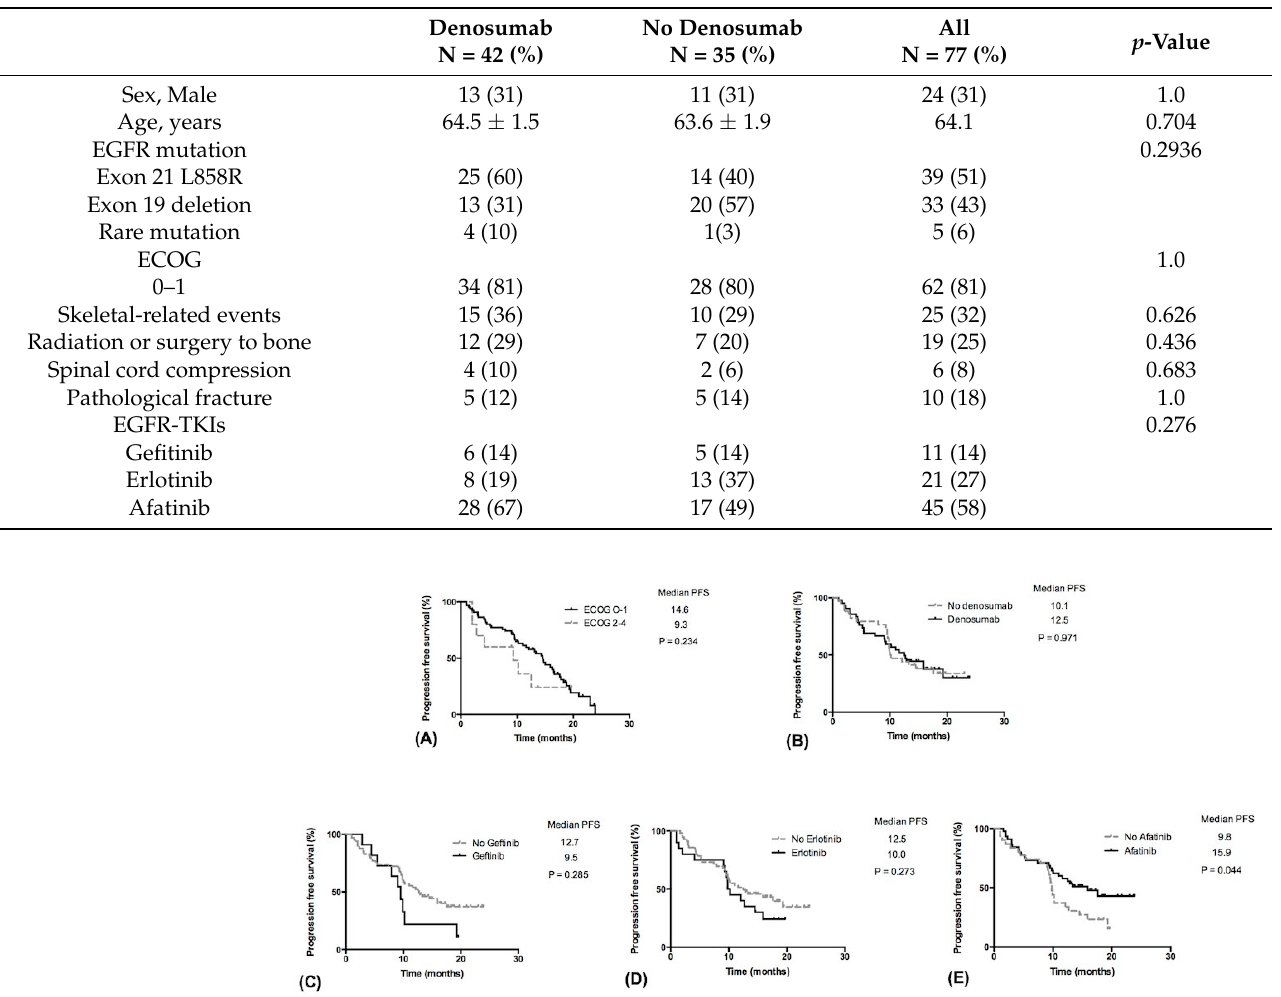
Table 1. Patient characteristics.